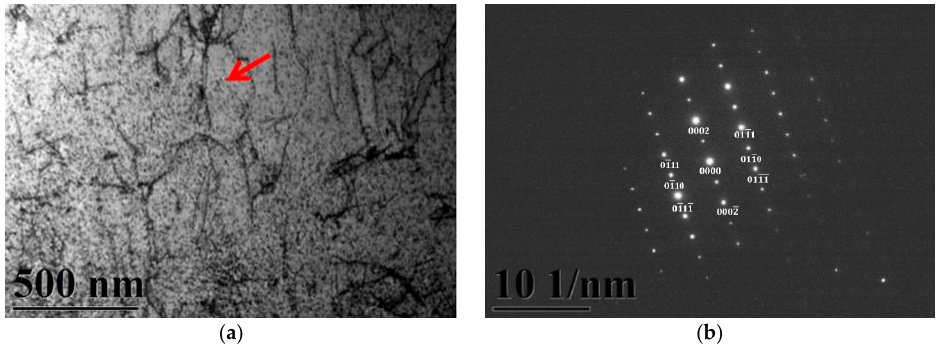
Figure 5. TEM image of the specimen aged at 450 °C for 16 h (Sample C). ( a ) Bright ‐ field image of the ferrite matrix; ( b ) SADP, revealing that g = 1120 was a Cr 2 N precipitate. The arrow indicates the precipitated particles.